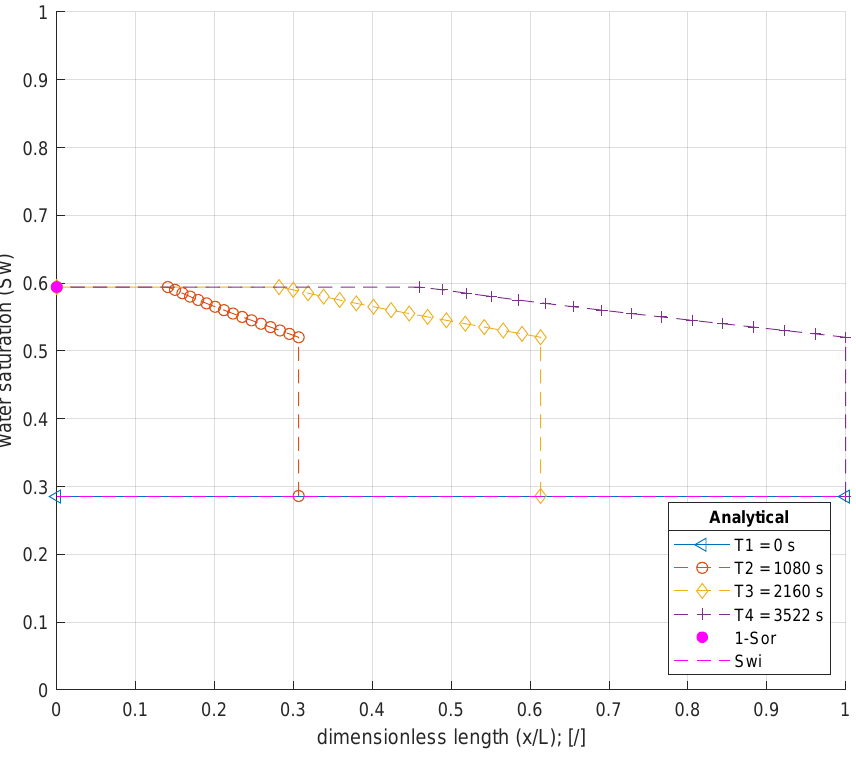
Figure 11. Analytical frontal advance displacement (M =